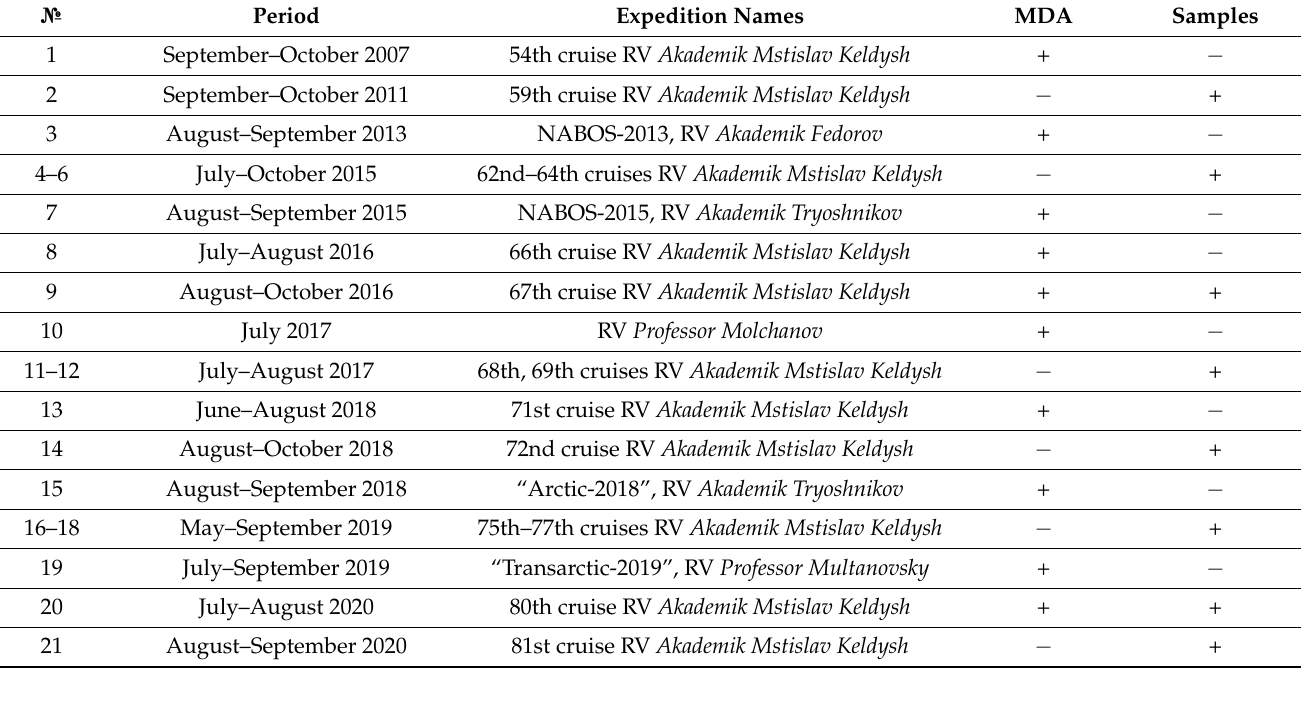
Table 2. Expeditions measuring black carbon concentrations (MDA—instrumental measurements; Samples—sampling for filters).